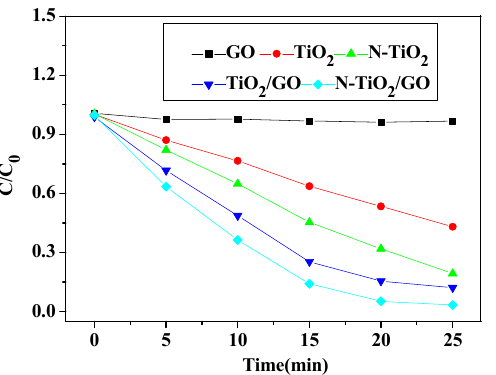
Figure 9. Relationships between the RhB photodegradation rates and illumination time of the different samples.